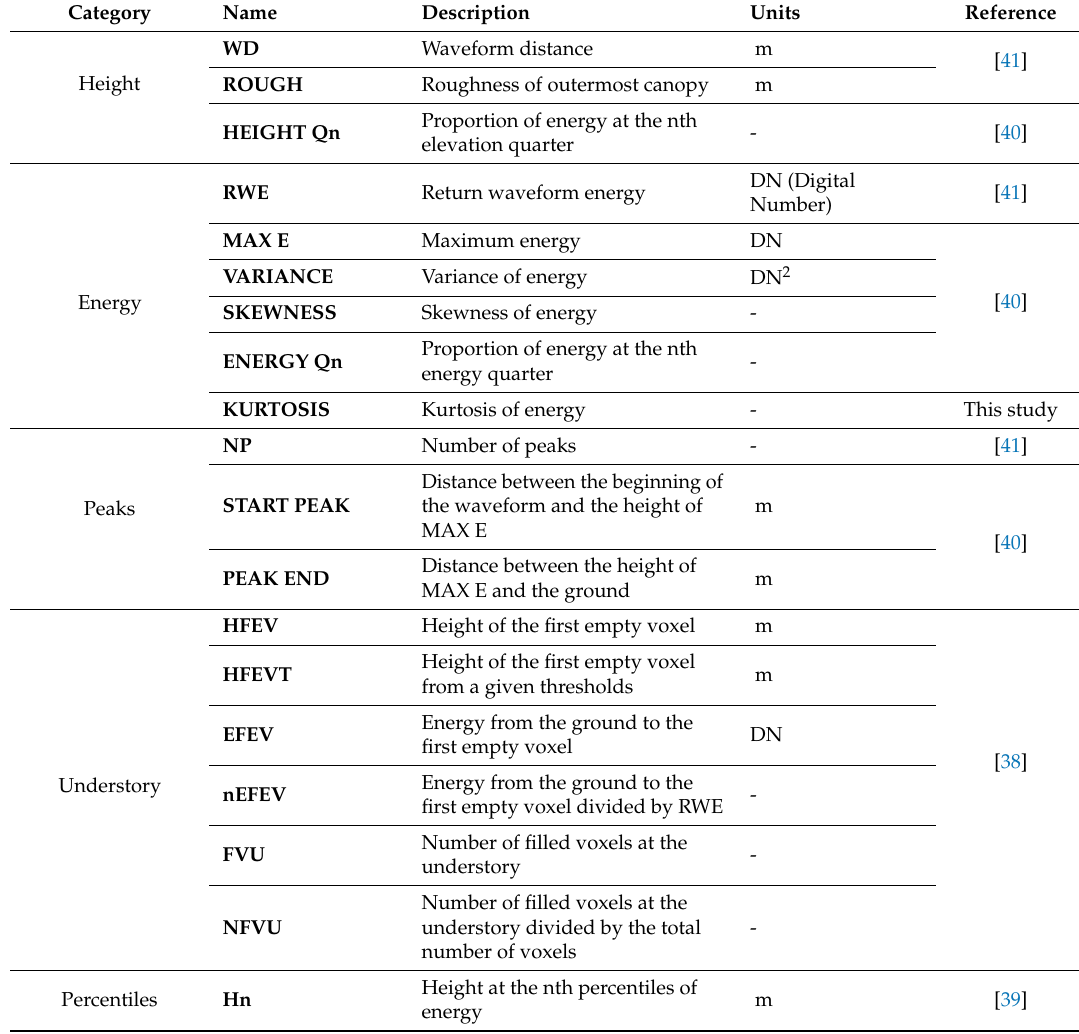
Table 1. Description of ALS FW metrics available in WoLFeX (adapted from Crespo-Peremarch et al. [38]).